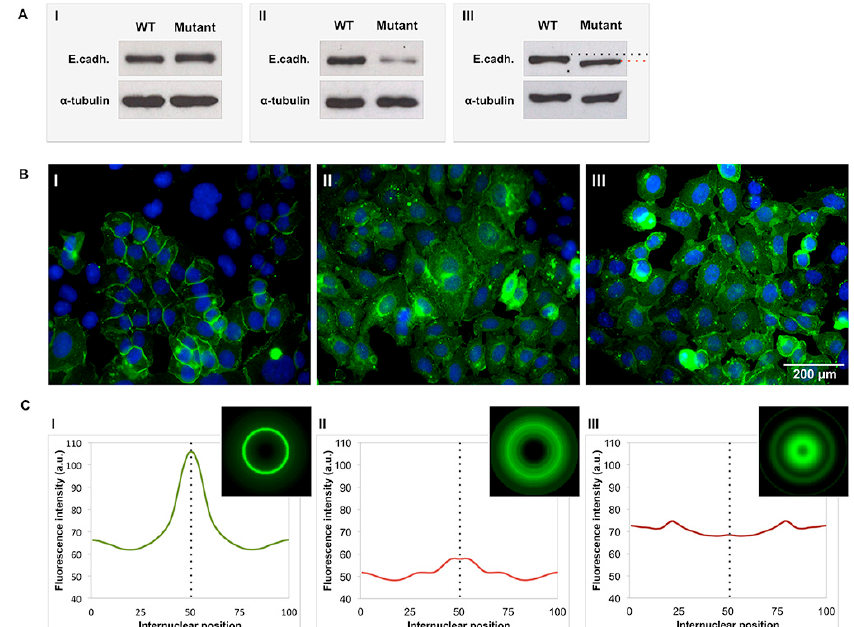
Figure 2. Representative E-cadherin expression profiles in cells with CDH1 missense variants found in the context of HDGC. ( A ) Chinese Hamster Ovary (CHO) cells transfected with different CDH1 missense variants were analysed for total E-cadherin expression levels by Western blot. Demonstrative images of normal expression level ( AI ), low expression ( AII ) and abnormal glycosylation ( AIII ) of the protein are shown. Small dots in ( AIII ) represent band mobility shift of total E-cadherin. Tubulin was used as a loading control. ( B ) Immunofluorescence (IF) images (400×) of E-cadherin with a membrane phenotype ( BI ), diffuse subcellular localization ( BII ), and cytoplasmic accumulation ( BIII ). E-cadherin is labelled in green and nuclei are counterstained with DAPI (blue). ( C ) Average intensity of E-cadherin internuclear profiles (IN) and the corresponding virtual illustration, obtained through IF images of cells expressing CDH1 with distinct missense mutations. Examples for each type of protein accumulation are illustrated. Protein at the membrane, diffused throughout the cytoplasm and perinuclear accumulation of the protein are represented in ( CI ), ( CII ), and ( CIII ), respectively. (a.u.), arbitrary units. The data are in accordance to previously described methods [40,48,49] and emphasize the diversity of CDH1 missense variants phenotypes.